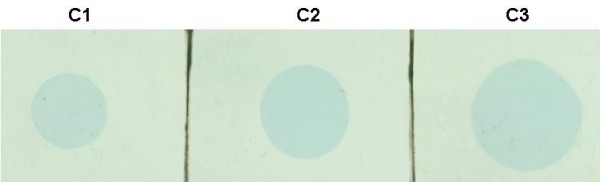
Digitized images of HS Gafchromic film exposed to nominal 2.5 Gy, using collimators C1, C2 and C3 (see Figure3).